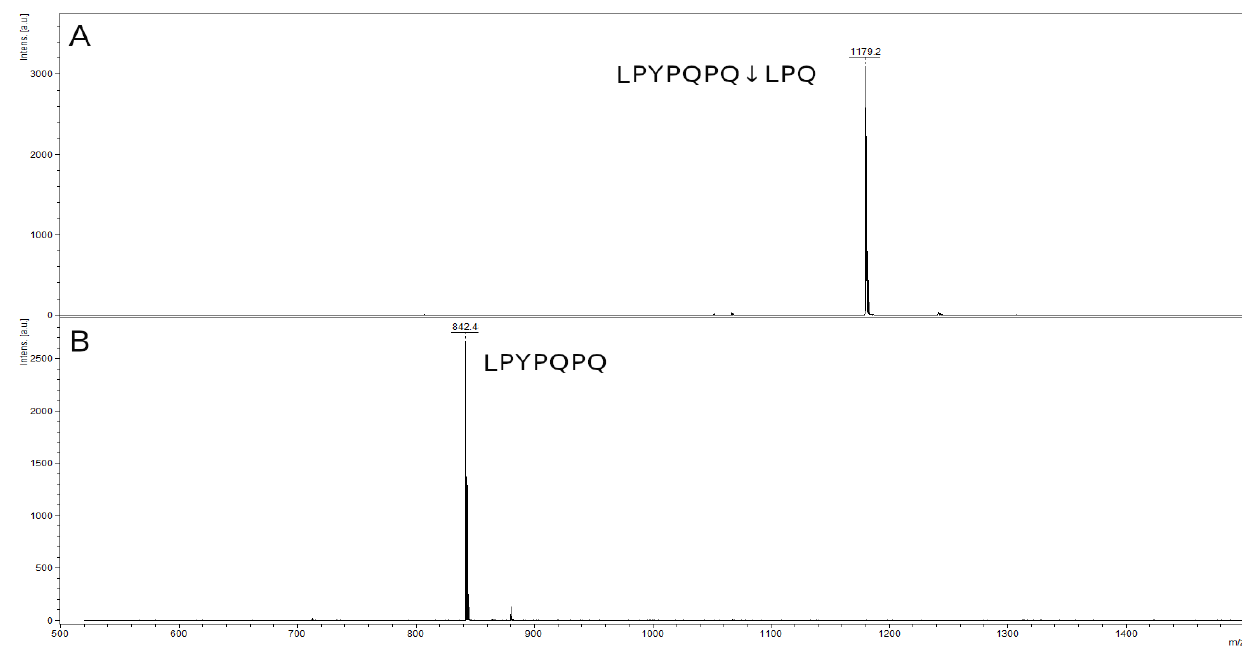
Figure 10. Mass spectra of the original 10-mer LPYPQPQLPQ peptide ( A ) and hydrolysate by rTcCathL1 after 40 min of incubation ( B ).